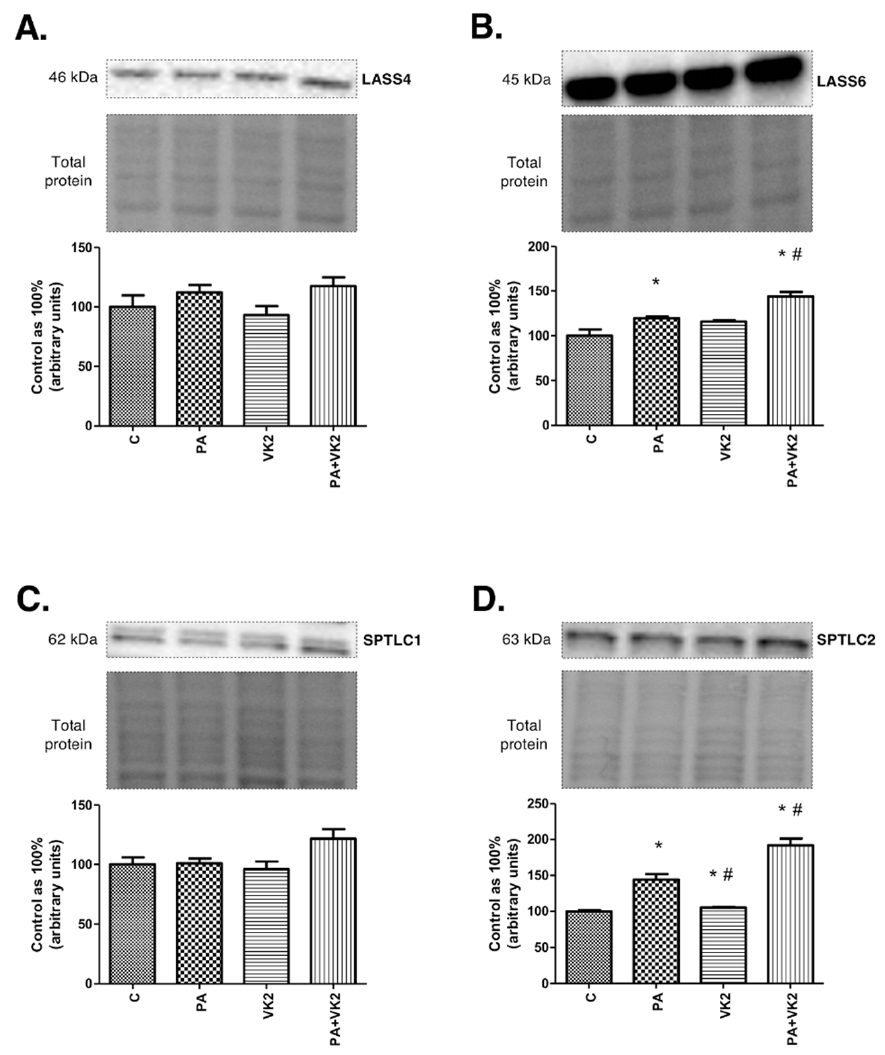
Figure 2. The expression of dihydroceramide synthase 4 (LASS4) ( A ), dihydroceramide synthase 6 (LASS6) ( B ), serine palmitoyltransferase 1 (SPTLC1) ( C ) and serine palmitoyltransferase 2 (SPTLC2) ( D ) in HepG2 cells. The cells were incubated for 16 h with palmitic acid and/or vitamin K2. The expression of enzymes involved in de novo synthesis and salvage pathways were assessed by Western blotting as described in the Materials and Methods section. The results are presented as mean ± SD and are based on six independent determinations. *— P < 0.05 significant difference vs control group, #— P < 0.05 significant difference vs palmitate group; C—control, PA—palmitate, VK2—vitamin K2, PA + VK2—palmitate and vitamin